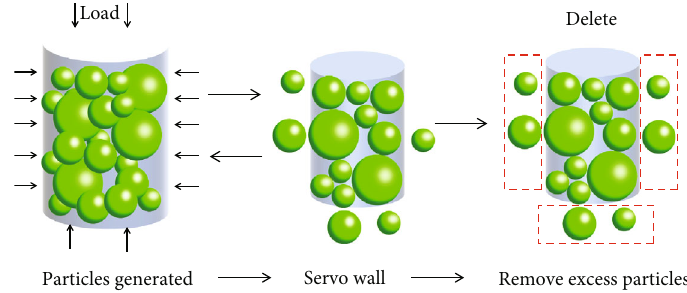
Figure 6: Homogenization process of the model. Table 2: Mesoparameter calibration of numerical simulation. Microparameters